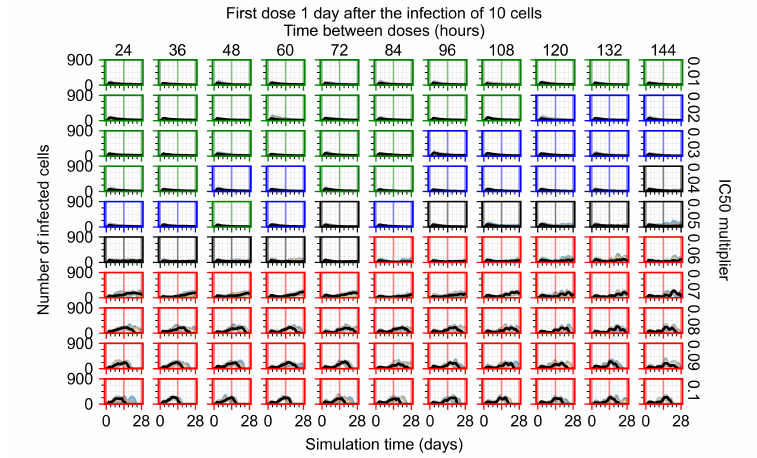
Figure A110. Infected (eclipse phase) population.